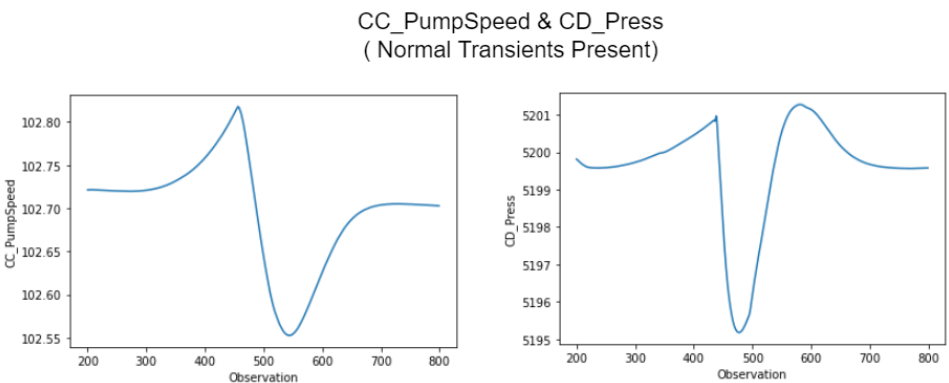
Figure 32. CC_PumpSpeed and CD_Press simultaneous transients.